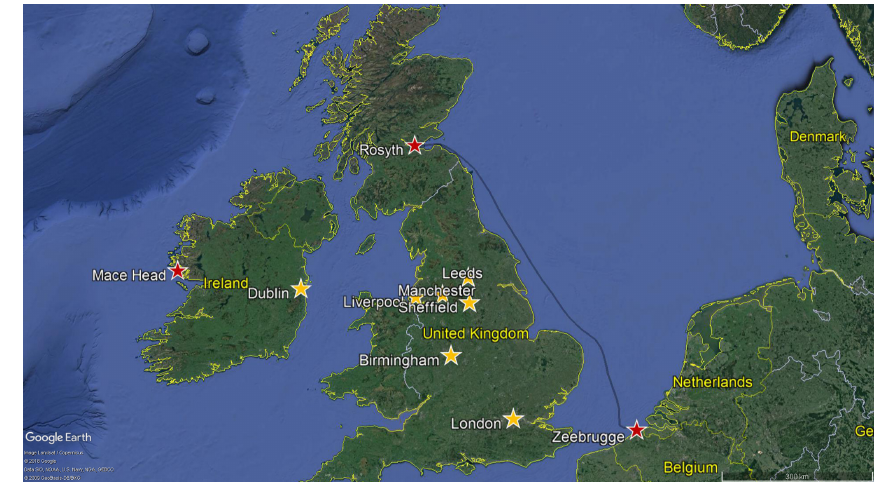
Figure 1. Google Earth map centred on the United Kingdom and Ireland. The route of the ferry is indicated by a dark blue line joining the ports of Rosyth (Scotland, UK) and Zeebrugge (Belgium). The location of the Mace Head measurement station on the west coast of Ireland, which provided the carbon dioxide and methane concentration baselines, is indicated by a red star. The cities indicated by yellow stars are locations of interest cited in the Discussion (Sect.